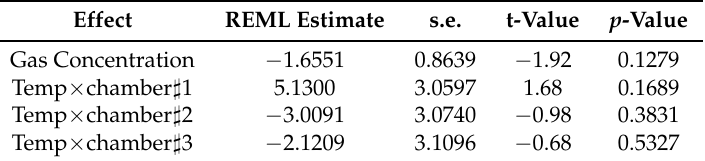
Table 4. REML estimates for random effects of Model (5) related to NO 2 .